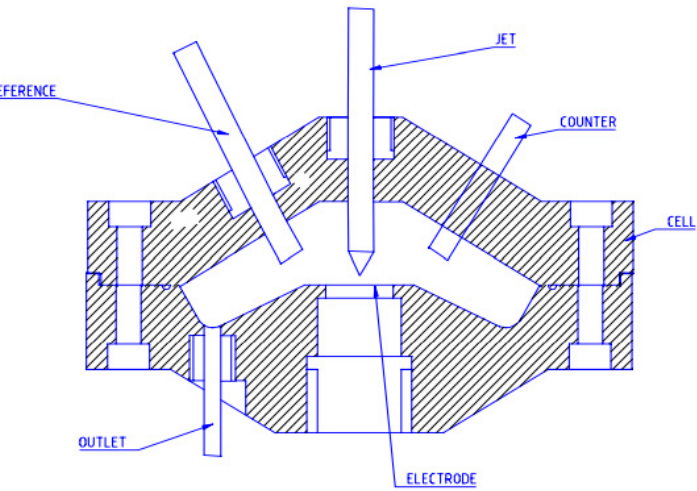
Figure 14. The scheme of jet impingement cell [127].